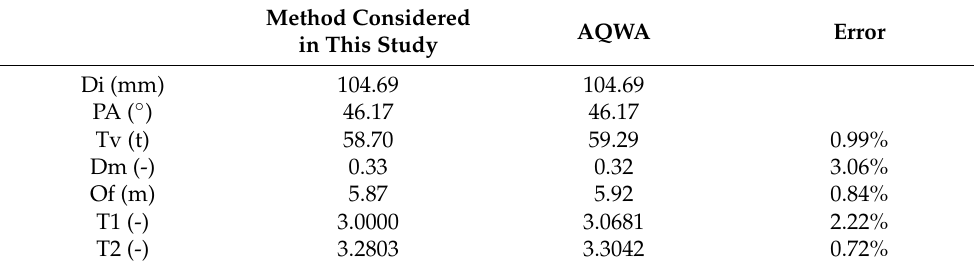
Table 3. Secondary function adaptive sampling optimization results.